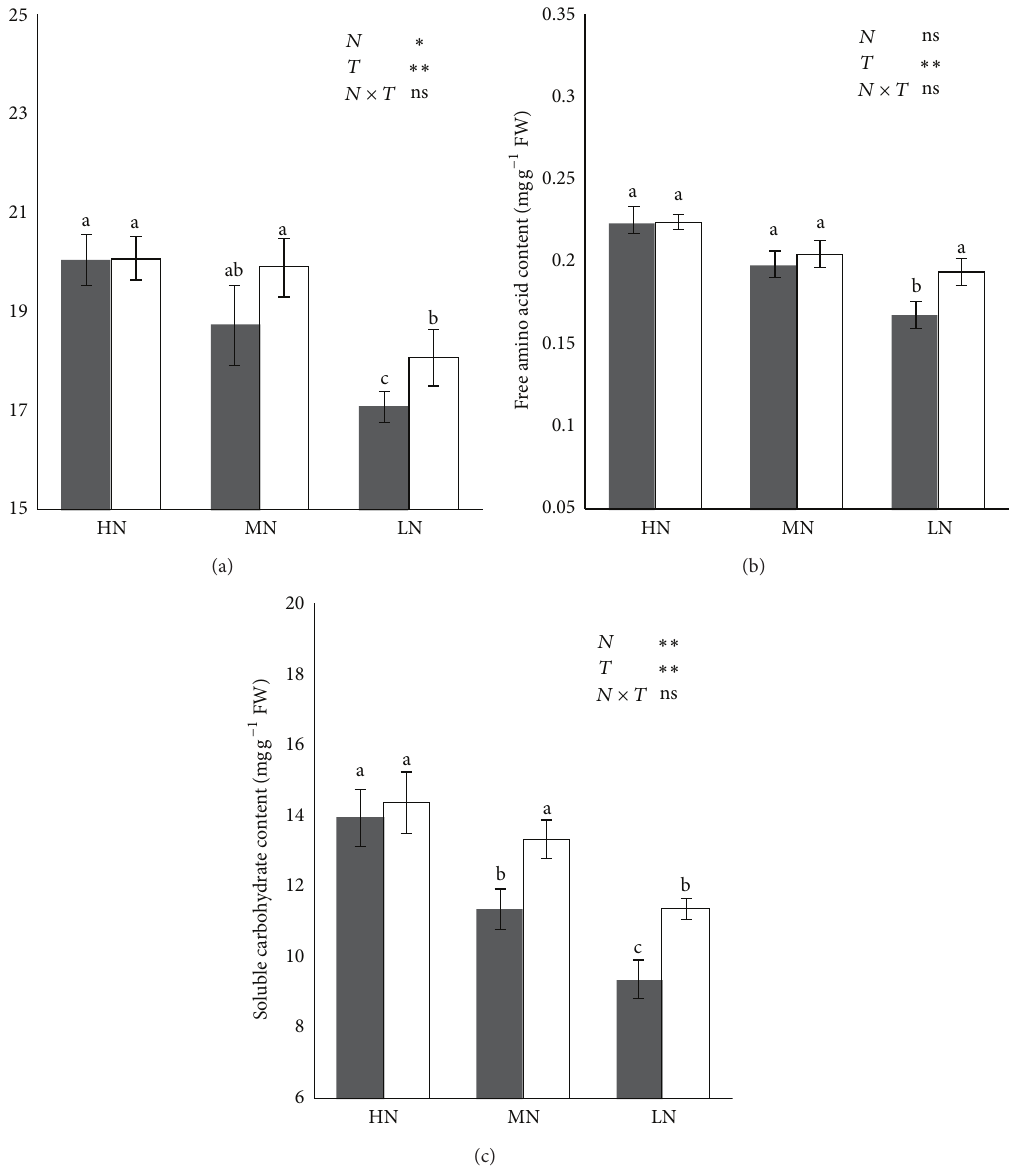
Figure 3: Leaf soluble proteinscontent (a), solublesugarcontent (b),and freeamino acid content (c) ofrice seedling. Plants were grown under two temperatures of 22 ∘ C (CK) and 27 ∘ C (HNT) with three nitrogen levels of 10mg N/L (LN), 40 mgN/L (MN), and 160mg N/L (HN). Range bars indicate the standard deviation ( 𝑛 = 3 ). ANOVA results are embedded in the figure: ns: not significant; ∗ 𝑃 < 0.05 ; ∗∗ 𝑃 < 0.01 . Columns with the same letter are not significantly different at 𝑃 < 0.05 by Tukey’s